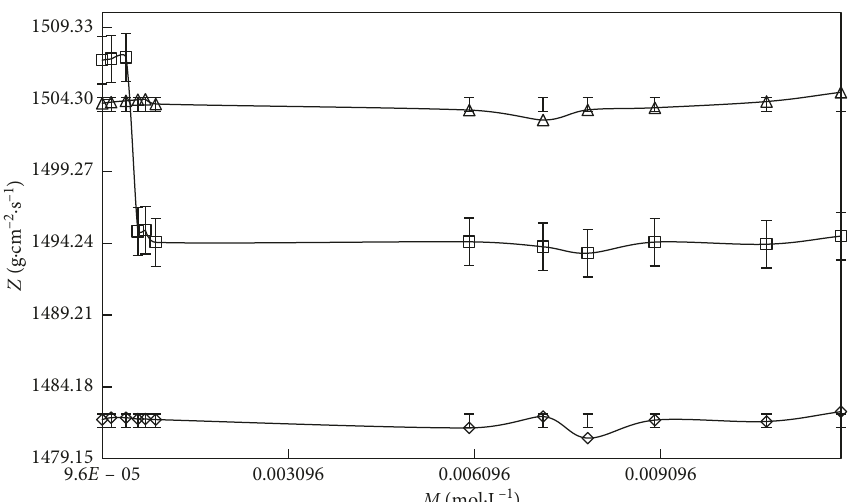
Figure 4: The Z value of the SDS-rich surfactant at the three different temperatures T � 293.15 ( ◊ ), 298.15 ( □ ), and 303.15K ( △ ), respectively.